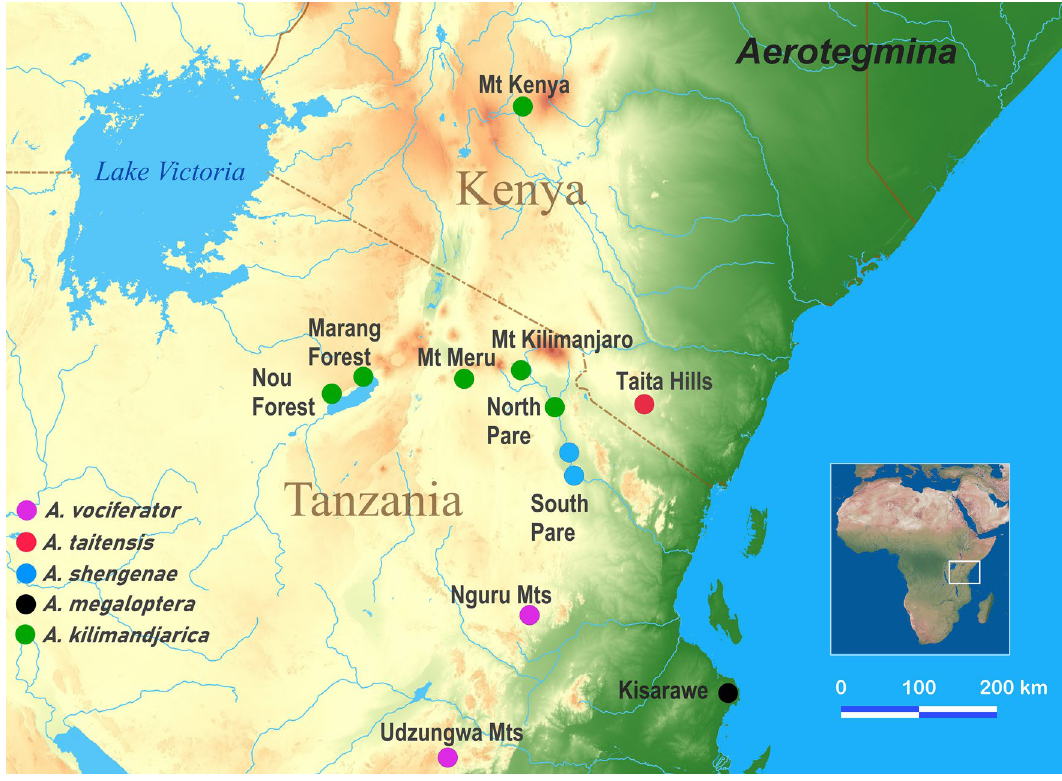
Figure 1. Map of collecting localities of analyzed specimens of Aerotegmina . Created by B. Grzywacz using QGIS 3.6 ‘Noosa’ (http:// qgis. osgeo. org) 82